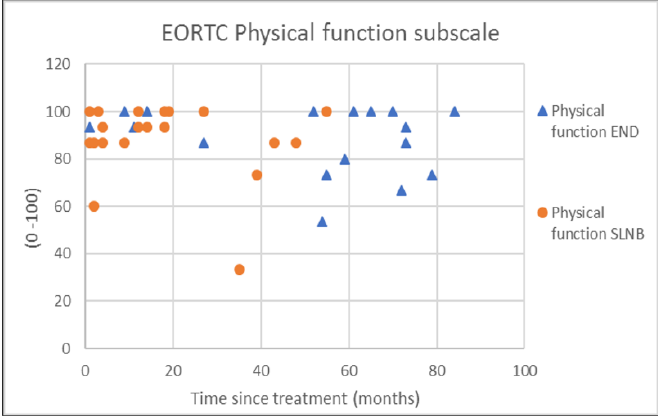
Figure 6. EORTC HR-QoL C30 Physical function subscale in relation to time since treatment.